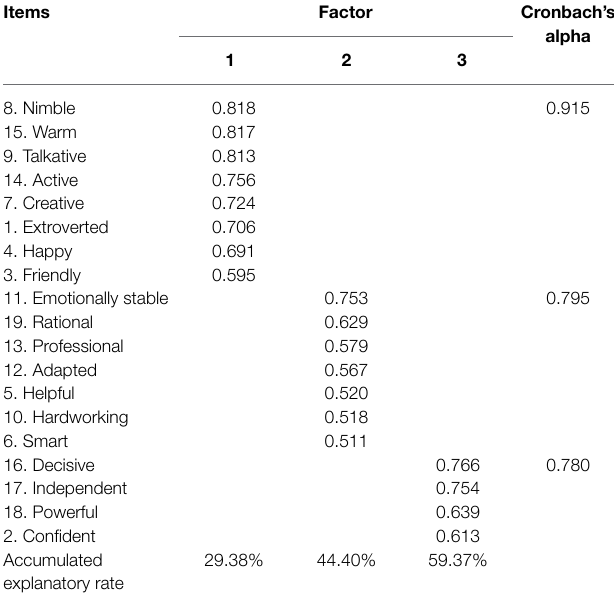
TABLE 3 | Factor analysis